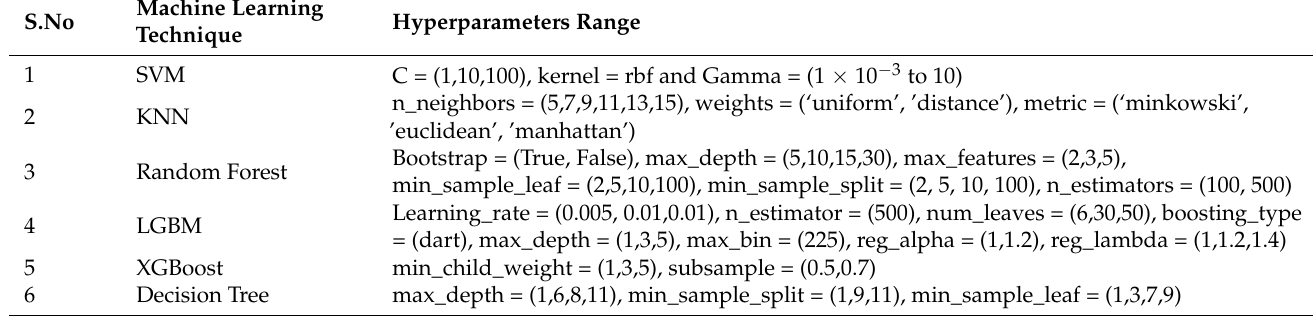
Table 2. Details of the Machine Learning Classifiers.